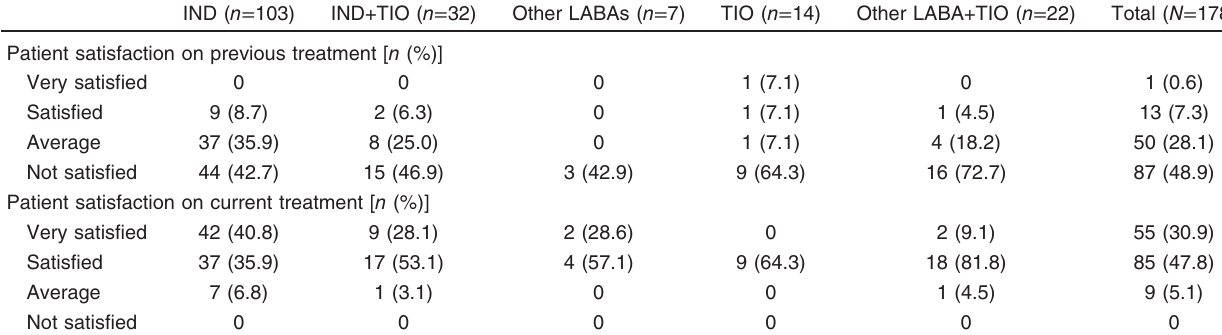
Table 2 Patient satisfaction with previous treatment and current